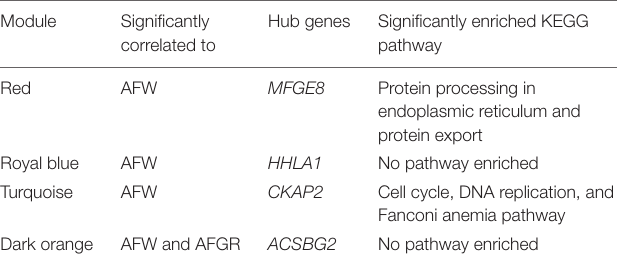
TABLE 2 | The identified hub genes, transcriptions factors (TFs), and enriched